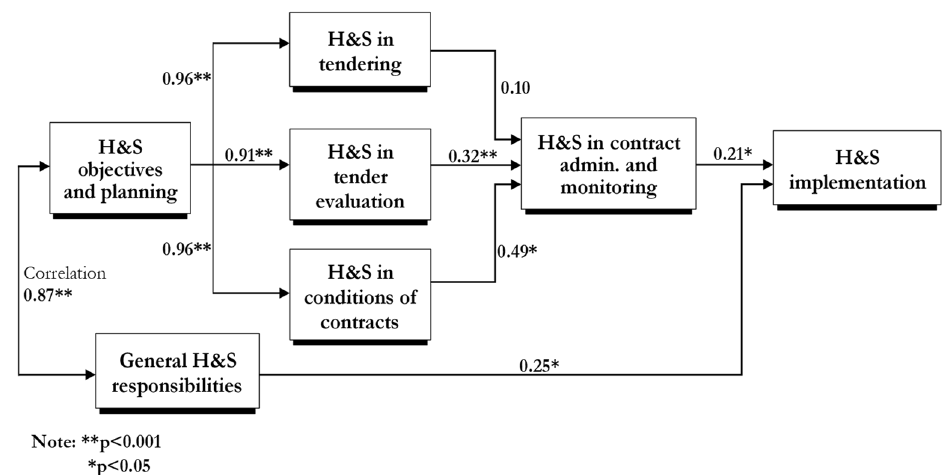
Figure 3. Model for promoting H&S through the procurement process.